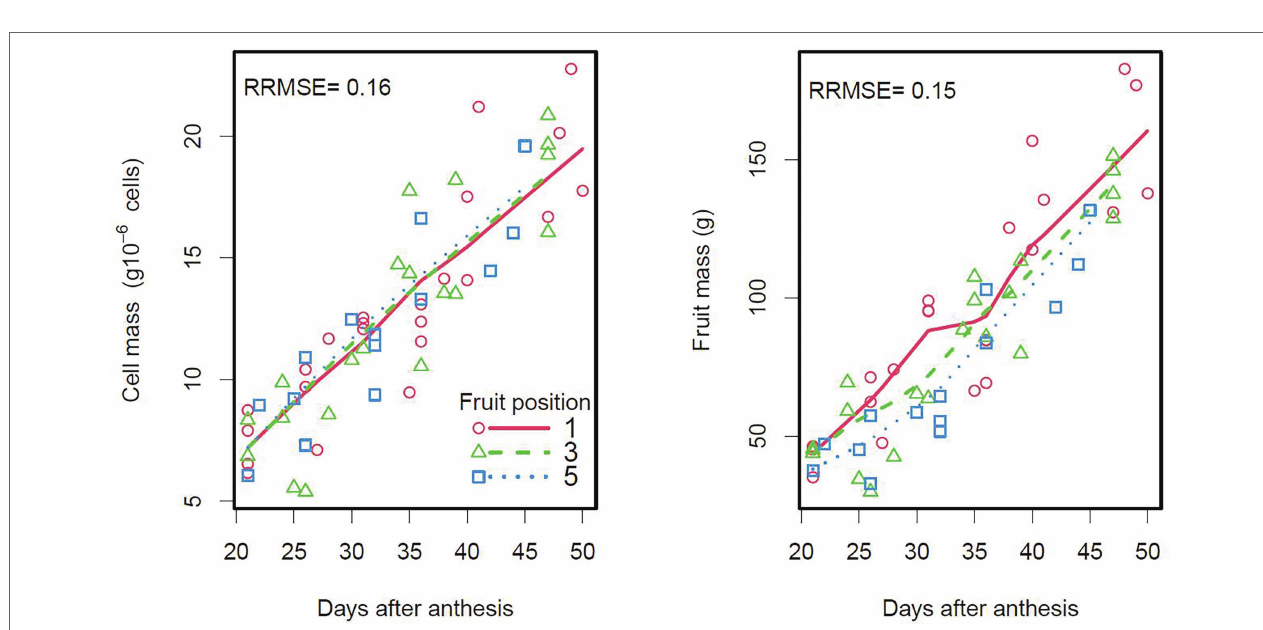
FIGURE 3 | Box plot of the parameter values estimated for each level of organisation. A logarithmic scale was used for parameter κ .